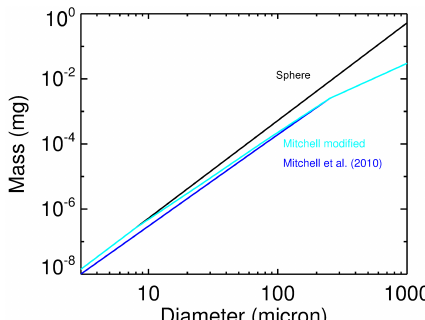
Figure 3. m – D relationship for spheres (black) and cirrus cloud particles (blue), as in Mitchell et al. (2010), and the modified rela- tionship for this analysis